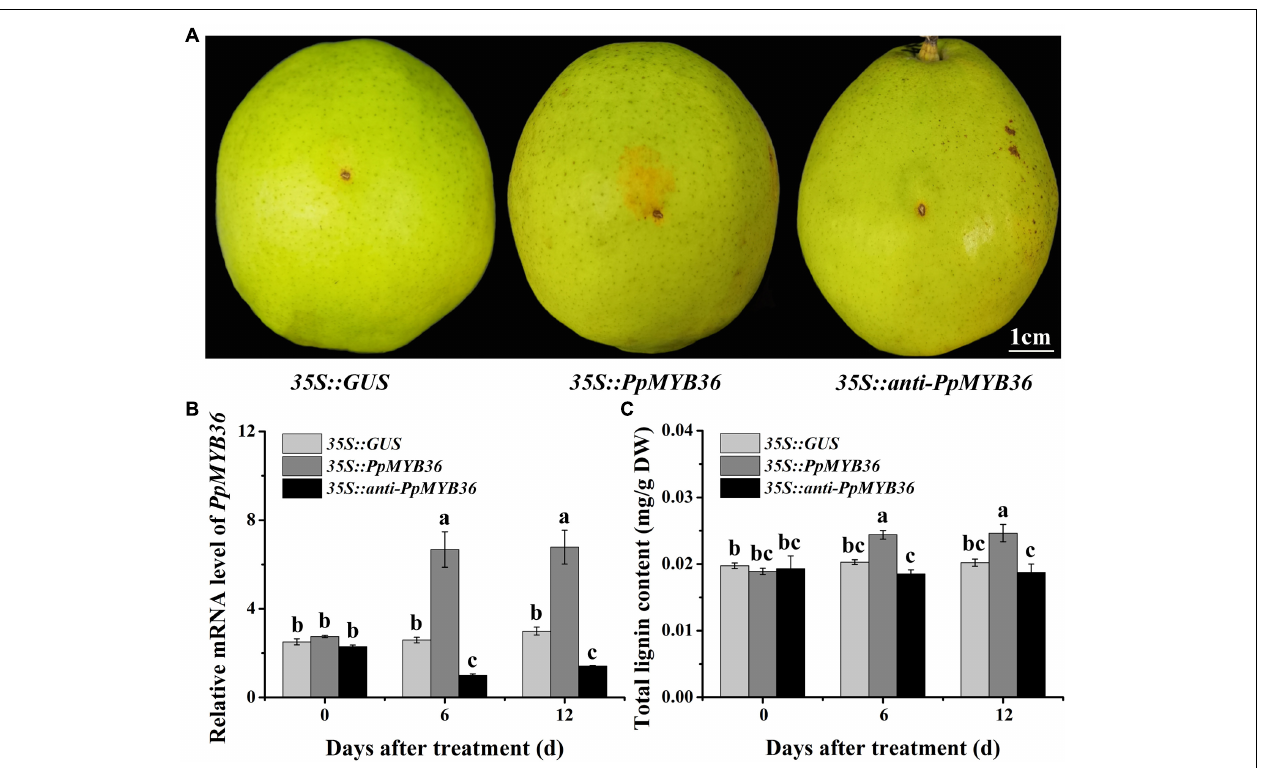
FIGURE 6 | Overexpression or silencing of the PpMYB36 gene in pear fruit skin. (A) Skin phenotypes of infiltrated fruits. (B) Relative expression levels of PpMYB36 and (C) concentration of lignin in the skins of infiltrated fruits. Different lowercase letters above bars mean significant differences among the treatments by Tukey’s multiple range tests ( p <